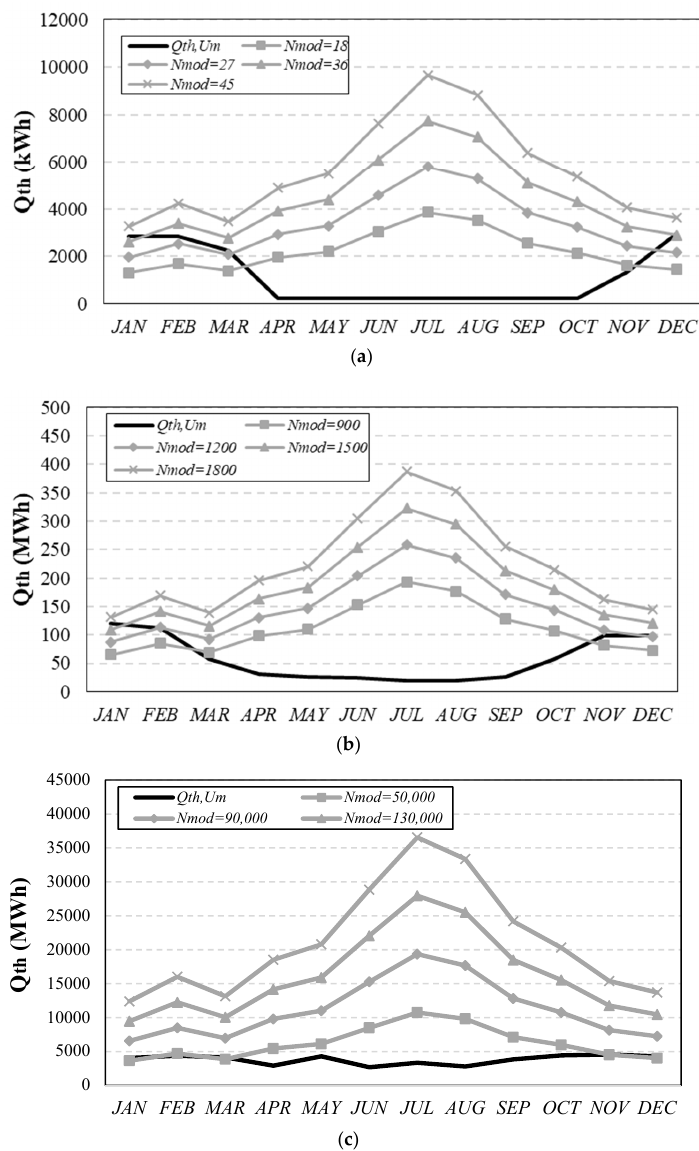
Figure 5. Difference between the CPV/T system thermal outputs on a monthly basis by varying its number of modules and the thermal loads of the three users: ( a ) house; ( b ) hotel; and( c ) industry.